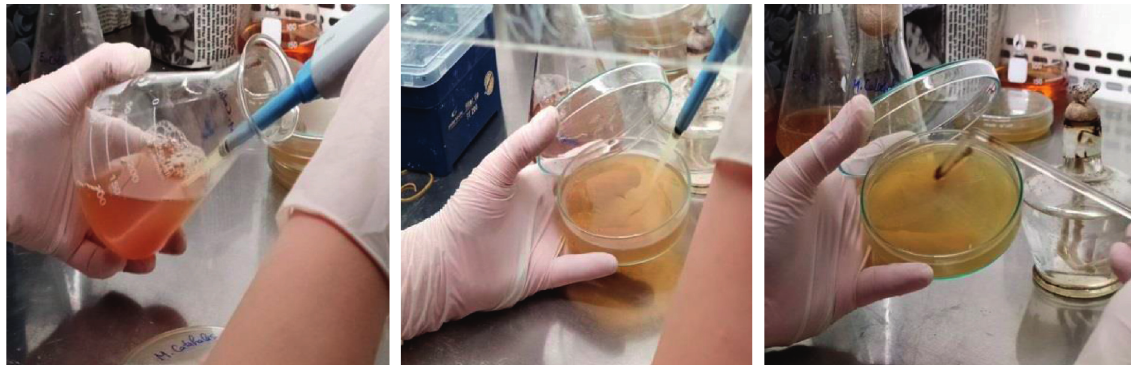
Figure 14: Steps to apply bacteria to agar